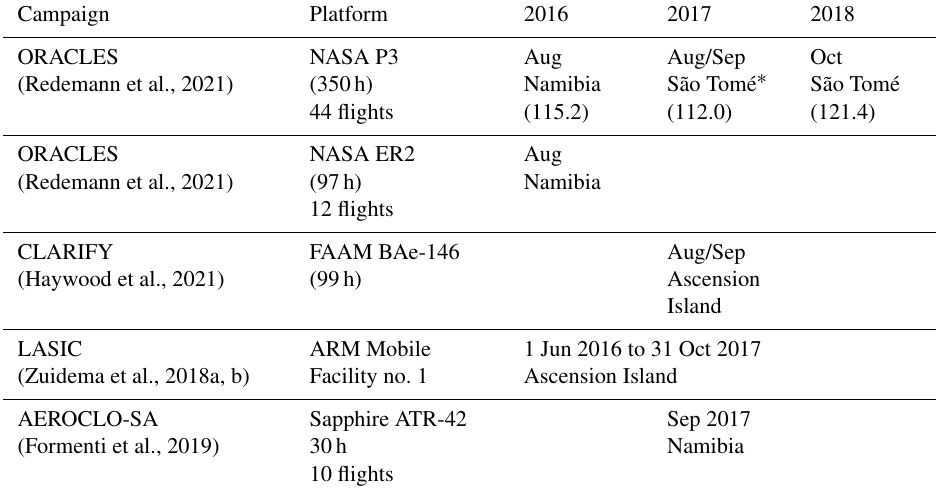
Figure 1. The observation platforms during (a) CLARIFY: the FAAM BAe-146; (b) ORACLES: the NASA P3; and (c) LASIC: ARM Mobile Facility no. 1. (d) The location of the ARM Mobile Facility no. 1 on Nasa Road, Ascension Island. This photograph was taken looking approximately north-north-east, showing the site exposed to the prevailing south-westerly winds. Table 1. Deployments of ground-based and airborne measurements in the south-eastern Atlantic during three biomass burning seasons from 2016 to